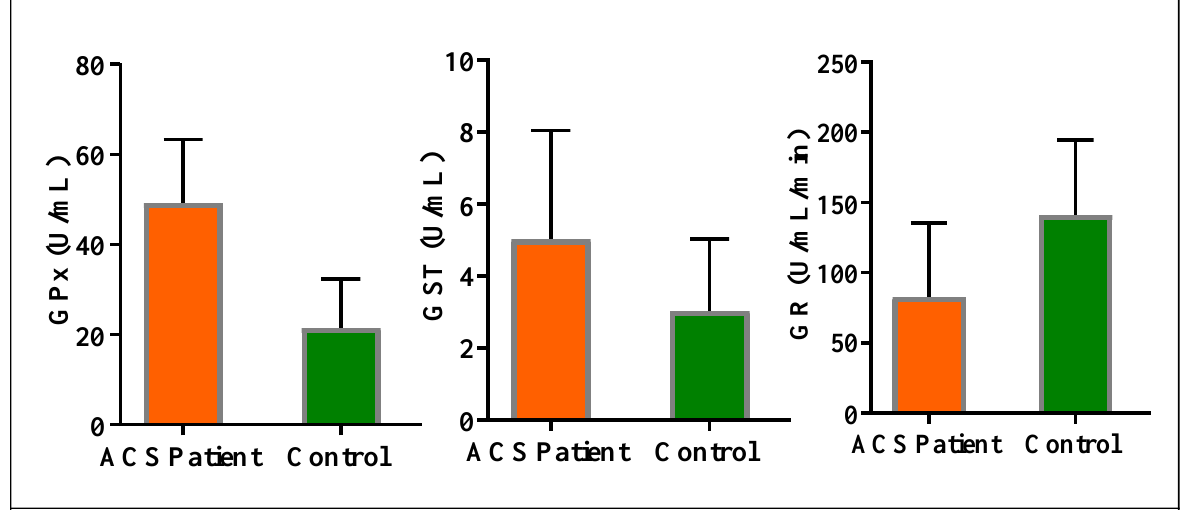
Figure 3: Comparison of vascular glutathione-associated enzyme activities in ACS patients and control subjects. The ACS patients had significantly higher plasma GPx activity ( p < 0.0001), significantly higher serum GST activity ( p < 0.001), and significantly lower plasma GR activity ( p <0.0001) [Mann-Whitney U test]. GPx = glutathione peroxidase; GST = glutathione-S-transferase; GR = glutathione